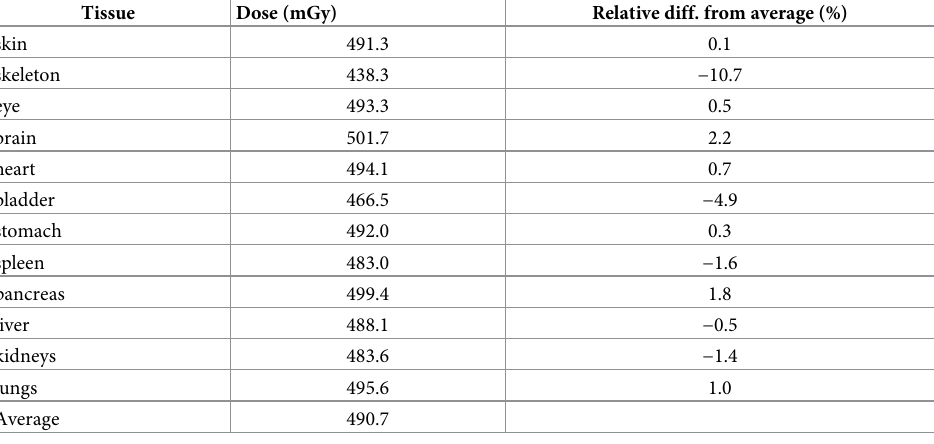
Table 5. Calculated “digirat” tissue and skeleton doses after nonisotropic (2-direction) irradiation with GCR sim- ulator